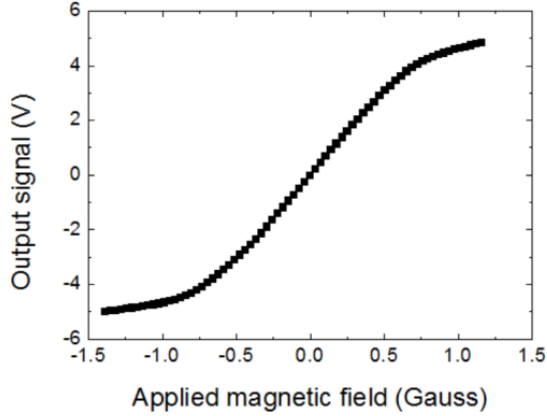
Figure 10. Magnetic response of the FeCoSiB amorphous wire magnetic sensor.